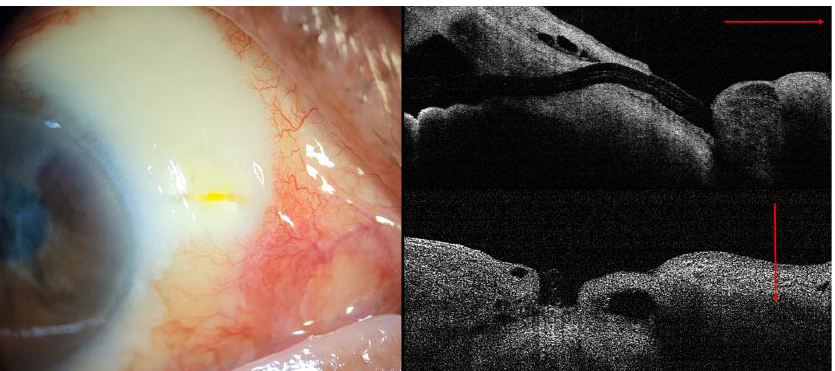
Figure 3. Slit-lamp examination and AS-OCT revealed the XEN gel stent exposure with small conjunctival defect due to conjunctival erosion (red line: linear scan on AS-OCT).